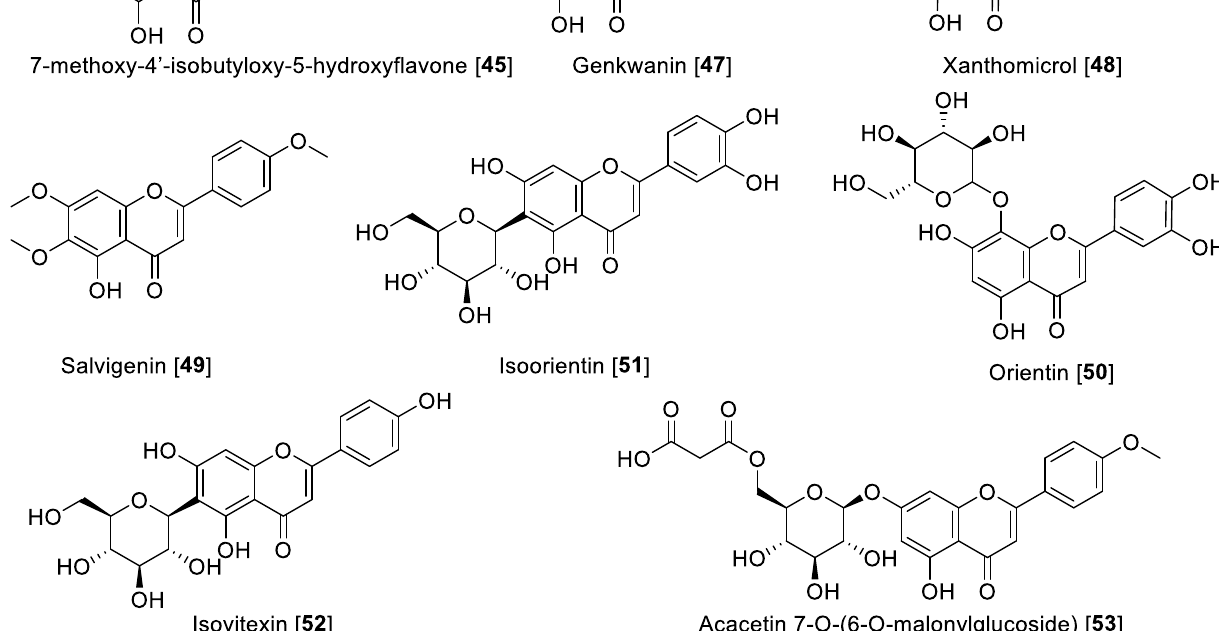
Figure 6. Chemical structure of selected flavone MAO inhibitors.